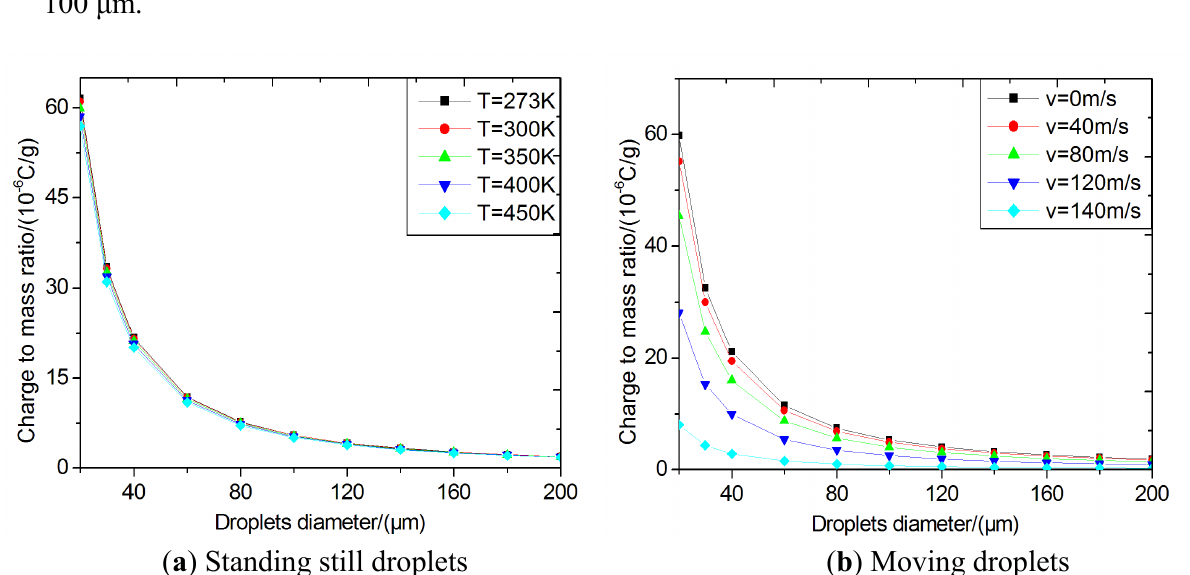
Figure 5. Critical specific charges using the stability criteria for strip break-up mode. ( a ) standing still droplets; ( b ) moving droplets; ( c ) moving droplets with a diameter of 100 μ